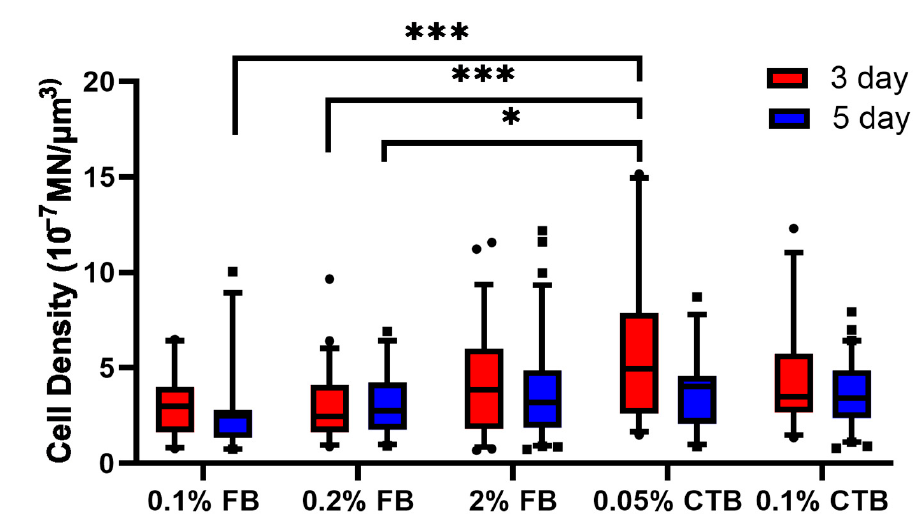
Figure 2. Density of labeled α -MNs among tracer protocols. α -MN density was measured as the number of labeled MNs per unit tissue volume from 3D z-stack images for all experimental groups of young mice (6–7 weeks). The number of cells analyzed per group (from left to right in order) is 73, 97, 168, 97, 272, 277, 169, 139, 130, and 260. Data are median ± 95% confidence interval. The circles and rectangles are data points outside the 95% confidence interval for the 3-day and 5-day protocols, respectively. *** denotes p < 0.001 and *denotes p < 0.05.